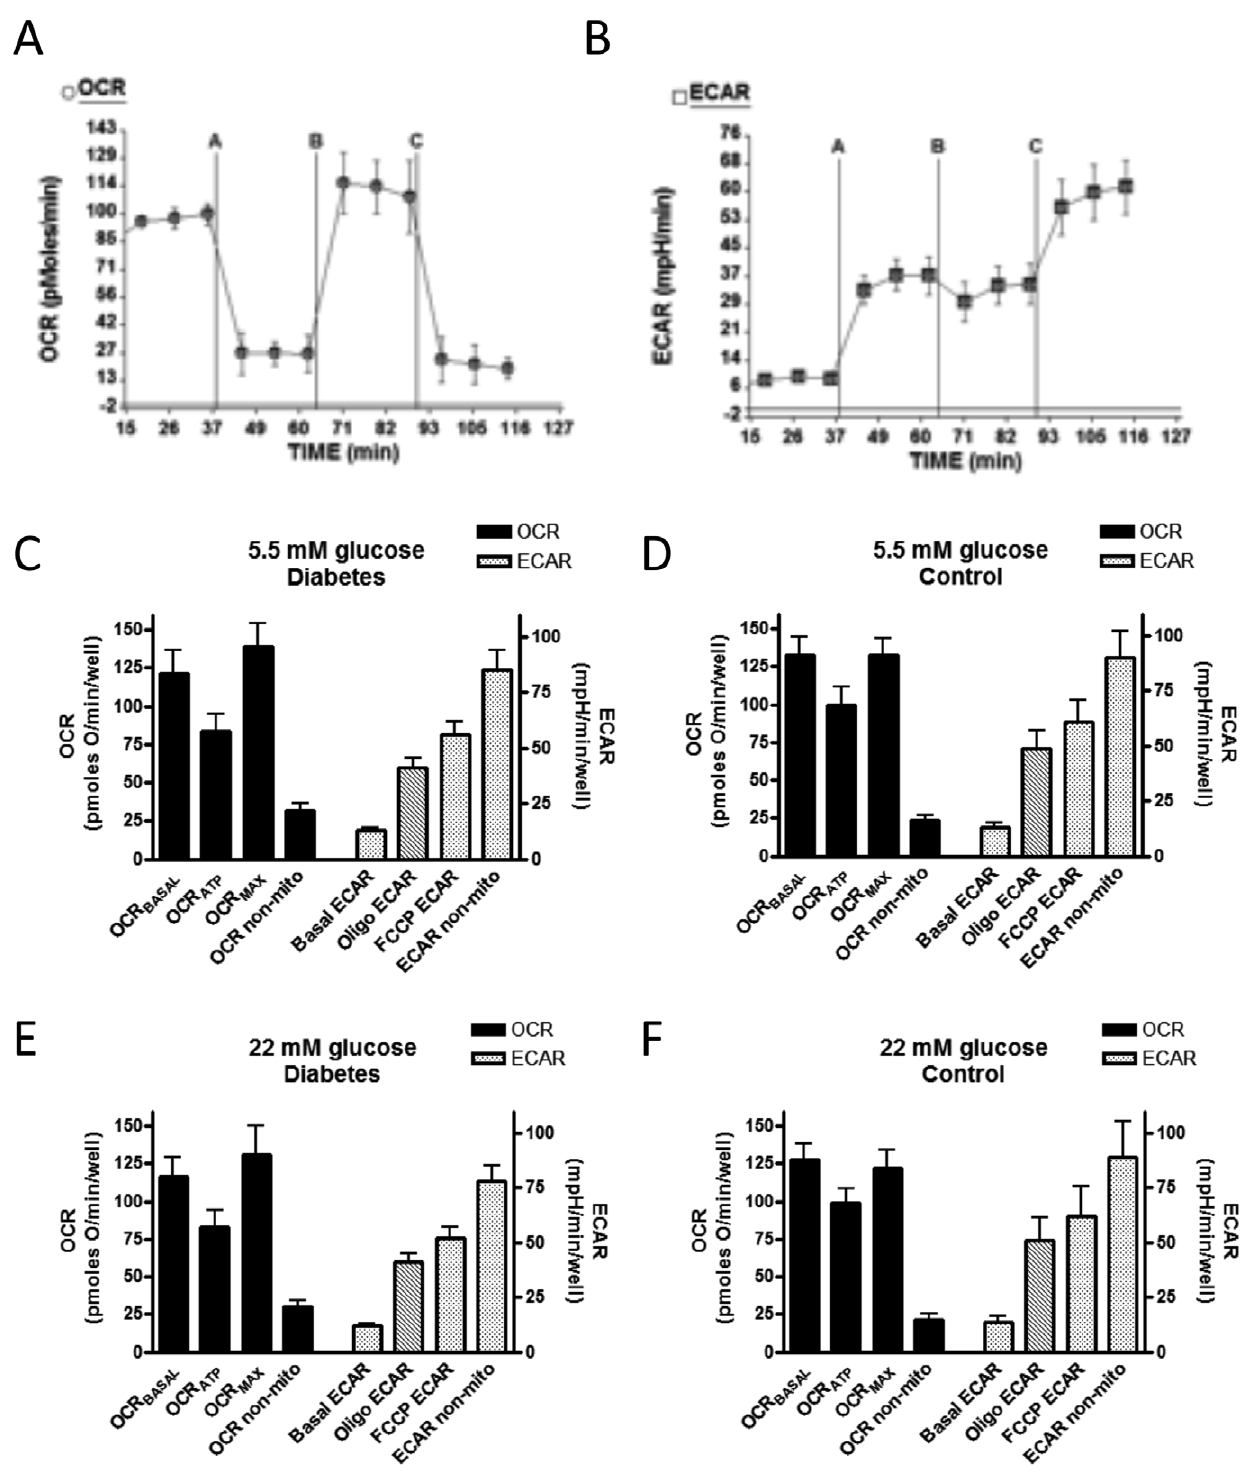
Figure 6. Effect of acute and antecedent ( invivo , before isolation) glucose exposure on human platelet mitochondrial function. Panels A and B) Representative tracings depicting OCR and ECAR by platelets (20 6 10 6 per well) isolated from a healthy (non-diabetic) subject as affected by sequential additions of oligomycin (2 m M, injection point A), FCCP (2 m M, point B), and antimycin A (0.5 m M) plus rotenone (2 m M, point C). Each data point represents the mean 6 SEM of 5 repetitions. Panels C-F) Calculated (see text) values for OCR BASAL , OCR ATP , OCR FCCP , and non- mitochondrial OCR and ECAR in diabetic and control subjects at 5.5 and 22 mM glucose (as specified in panel titles). Bars represent the mean 6 SEM, n=10 for diabetic subjects, n=5 for control subjects. Each data point for each subject represents a mean of 4–5 repetitions.